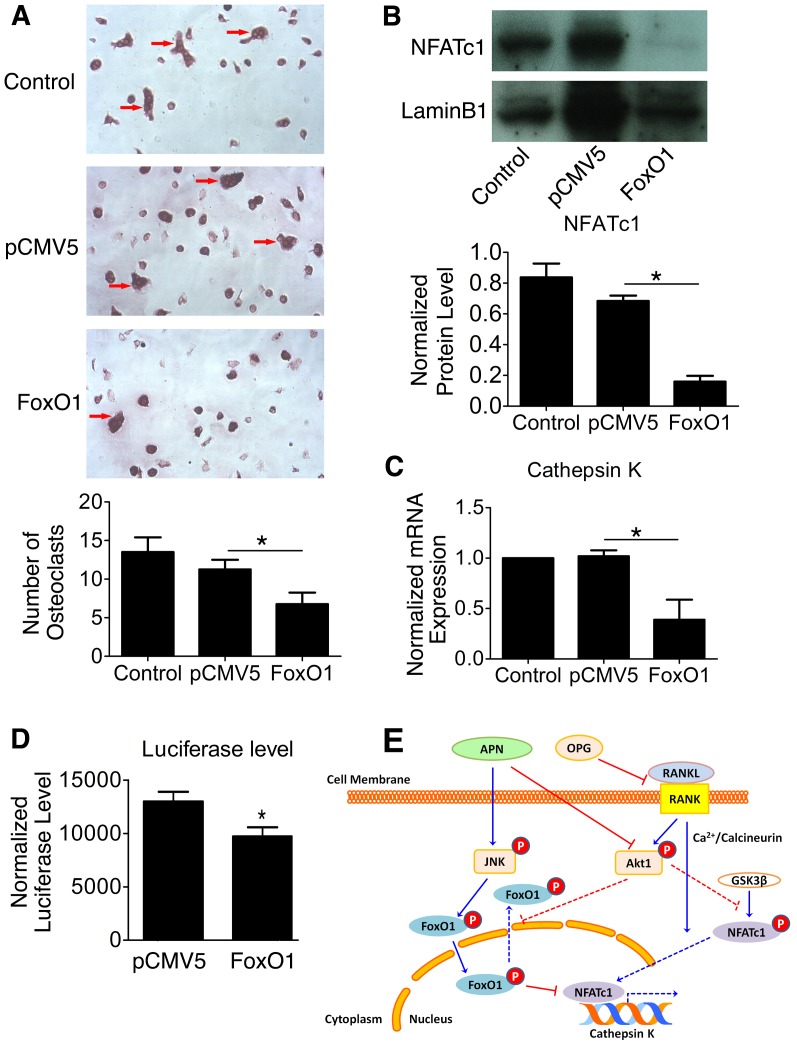
FoxO1 Over-Expression Inhibits RANKL-Induced Osteoclastogenesis by Down Regulating NFATc1.(A) BMMs isolated from WT mice were transfected with or without pCMV5 or Flag-FoxO1, and osteoclastogenesis was induced with 10 ng/ml M-CSF and 50 ng/ml RANKL for 7 days. TRAP staining was performed and the number of osteoclasts was manually counted in four separate fields (magnification, ×200; red arrows = osteoclasts). (B) Western blot for NFATc1 nuclear protein extracted from RAW264.7 cells, which were transfected with or without pCMV5 or Flag-FoxO1. Lamin B1 was detected as the loading control. Data are shown as mean ± SD of three independent experiments. *P<0.05. (C) qRT-PCR of cathepsin K mRNA levels in RAW264.7 cells transfected with or without pCMV5 or Flag-FoxO1 during osteoclastogenesis. The mRNA level was normalized to GAPDH. (D) Luciferase assay determined luciferase levels in RAW264.7 cells co-transfected with Flag-FoxO1 or pCMV5 (control) and pGL3-CtspK-luciferase reporter vector. (E) APN inhibition of RANKL-induced osteoclastogenesis through activation of FoxO1 and inactivation of NFATc1. APN promotes FoxO1 activation directly in a JNK-dependent manner and indirectly by inhibiting AKT phosphorylation [19] (data not shown). In the absence of APN, NFATc1, the master regulator of osteoclastogenesis [33], [34], is activated by RANKL in a Ca2+/calcineurin-dependent manner. In the presence of APN, NFATc1 nuclear translocation is inhibited indirectly by APN-mediated inhibition of AKT [19] and by a FoxO1-mediated mechanism. Inhibitory signaling by APN is depicted by red lines and stimulatory signaling is represented by blue lines. Dashed lines are used to represent signaling events that are diminished in osteoclast-precursor cells undergoing RANKL-induced differentiation in the presence of APN.